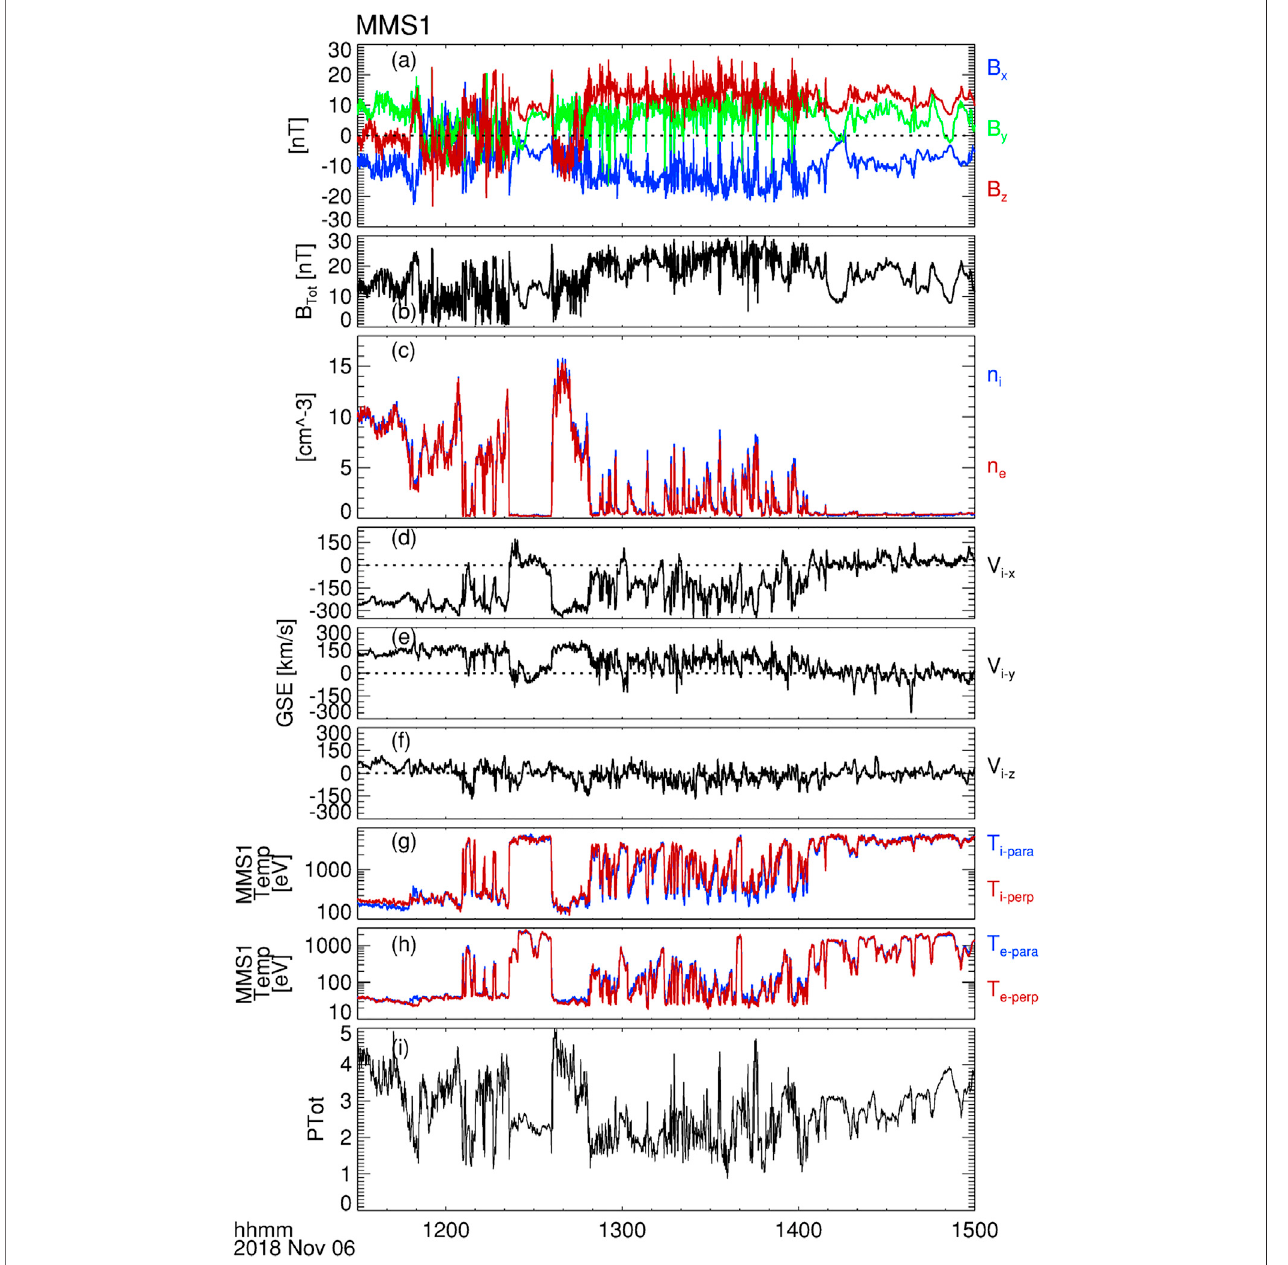
FIGURE 3 | MMS observations of the magnetic fi eld and plasma moments during the inbound traversal from the magnetosheath across the fl ank dusk magnetopause and into the magnetosphere. (A) Magnetic fi eld components in GSE coordinates; (B) Magnetic fi eld intensity; (C) Number densities of ions (blue) and electrons (red); (D) Ion bulk velocity component V xGSE ; (E) Ion bulk velocity components V yGSE ; (F) Ion bulk velocity components V zGSE ; (G) Perpendicular temperatures of ions (blue) and electrons (red); (H) Parallel temperatures of ions (blue) and electrons (red); and (I) Total static pressure (Sum of magnetic and thermal pressures).